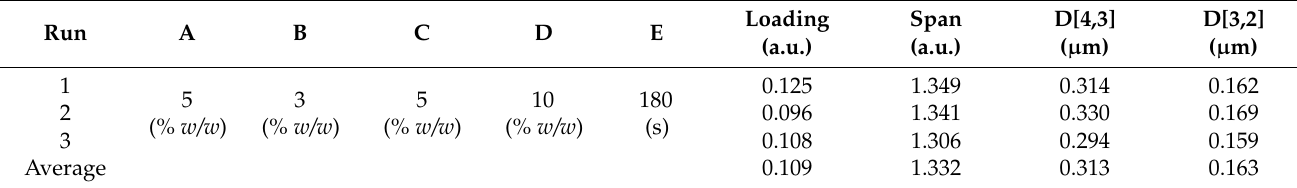
Figure 3 is a graphical representation of the polymerization reaction progress for 180